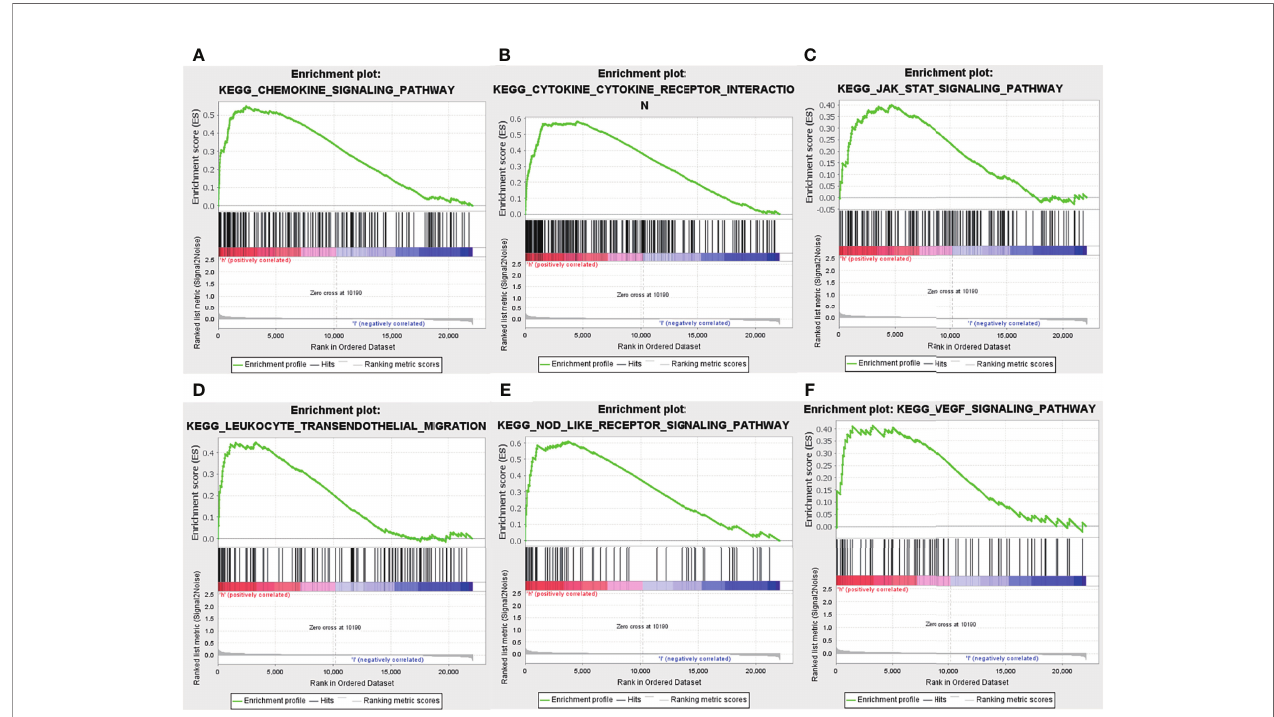
FIGURE 7 | Gene set enrichment analysis. Enrichment pathway between the high- and low-risk groups, including chemokine signalling pathway (A) , cytokine receptor interaction (B) , JAK-STAT signalling pathway (C) , leukocyte transendothelial migration (D) , Nod-like receptor signalling pathway (E) and VEGF signalling pathway (F) .